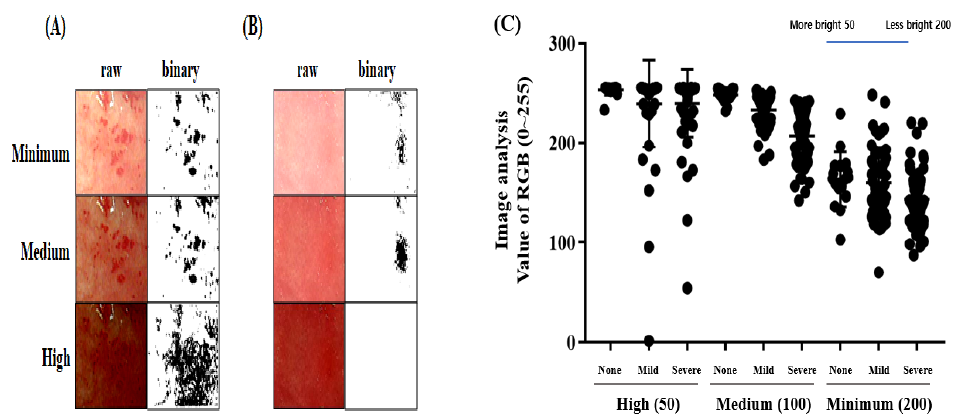
Figure 6. Measurement of gastric ulcers in clinical photographs under different light. The brightness of the images should be optimized enough to identify the symptoms of gastric ulcer/gastritis. In some cases, dark erythema is more clearly distinguished from the normal range as it is brightened ( A ), but light erythema is difficult to distinguish from normal if it is brightened beyond a certain range ( B ). However, when the photo’s light is not sufficient, it is difficult to discriminate the data value regardless of light or dark erythema ( A , B ). The gastric ulcer measurements in clinical specimens were analyzed with ImageJ ( C ). The photographs obtained from the first observation were set as the original data, and based on their brightness value, they were classified as high 50, medium 100, and low 200 by setting them as the white balance. The gastric ulcer measurements in clinical specimens were analyzed with different light intensities using ImageJ. The y-axis shows the value of RGB. RGB color has to be maintained between 0 and 255. The x-axis shows the high (50), medium (100), and minimum (200) brightness contrast.